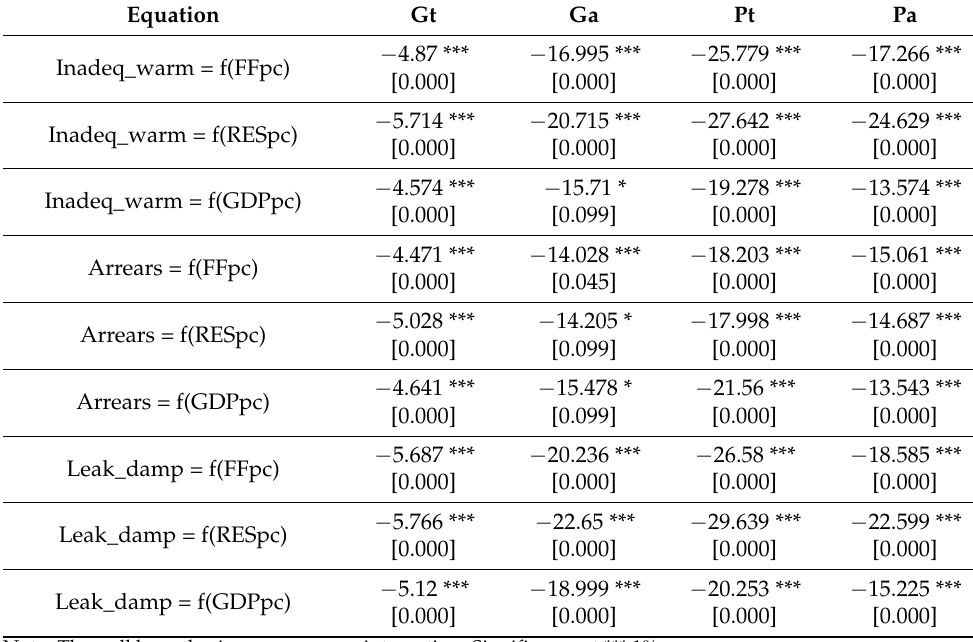
Table 5. Westerlund Panel Cointegration